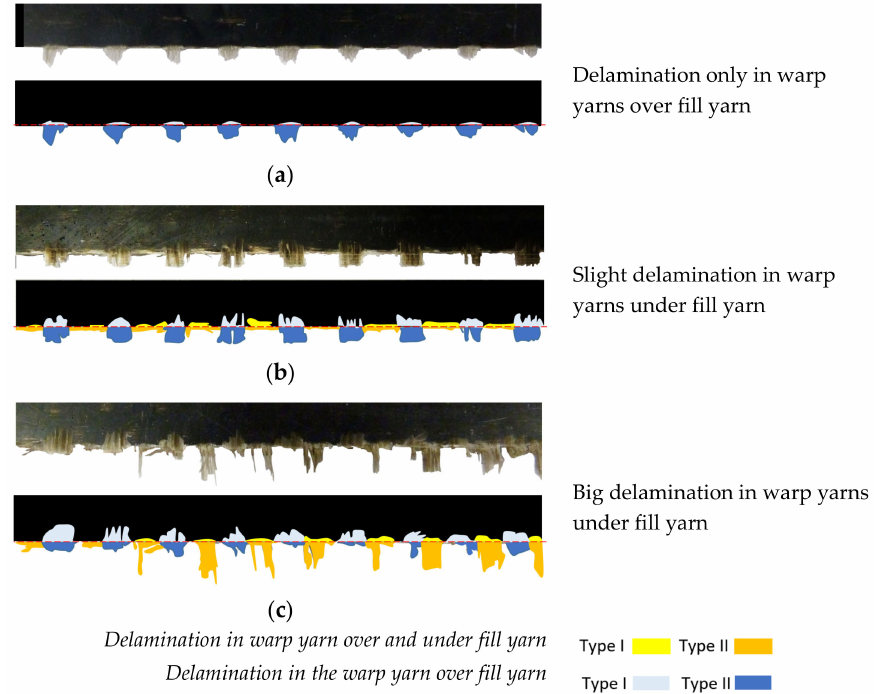
Figure 4. Delamination areas in 90 ◦ fiber orientation laminates. ( a ) Delamination in warp yarns over fill yarn ( b , c ) Delamination in warp yarns over and under the fill